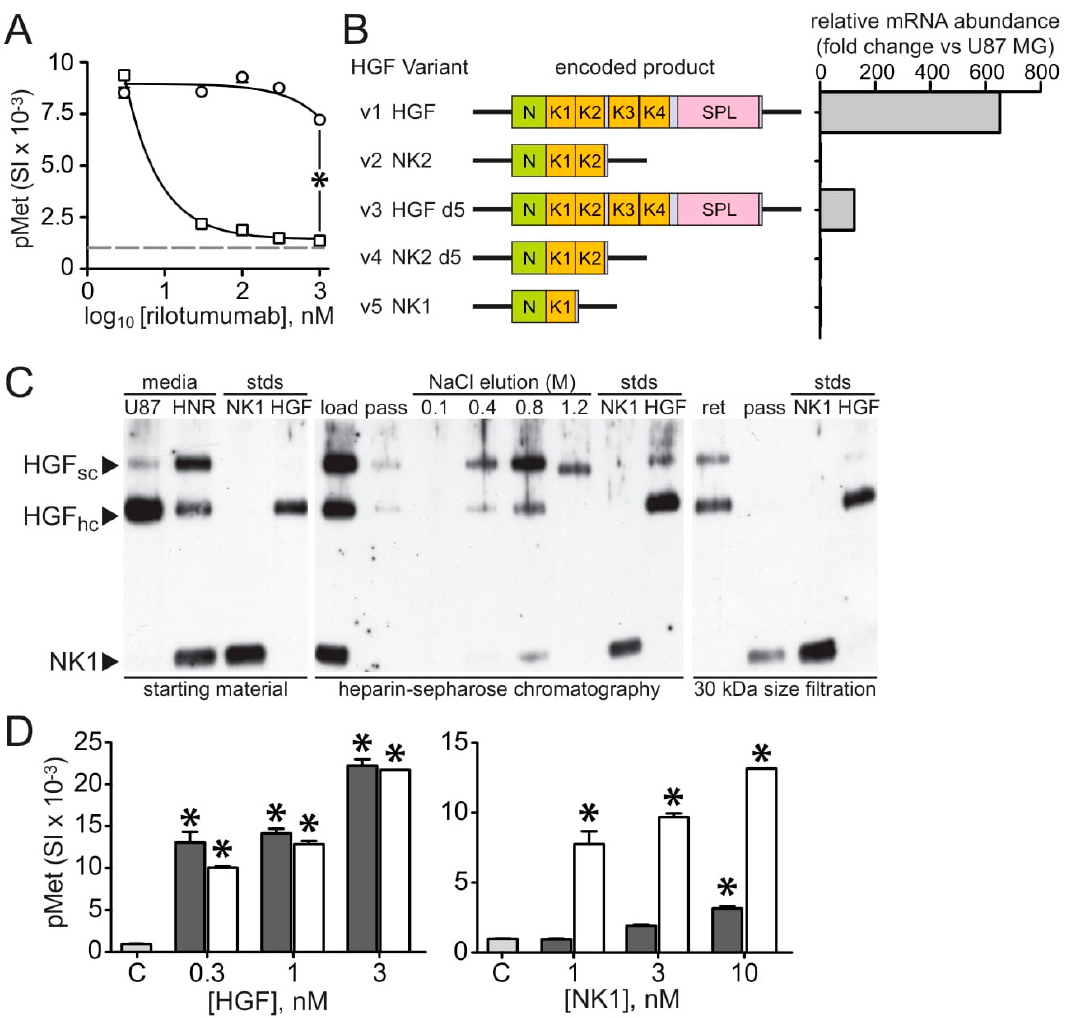
Figure 7. Potential route of rilotumumab resistance by production of a non-neutralizable trun- cated HGF protein. ( A ) Rilotumumab potently neutralizes Met autophosphorylation (pMet; mean signal intensity, SI ± SD, n = 3) in intact 184B5 cells induced by purified recombinant full-length HGF (squares) but not by the purified recombinant truncated HGF variant NK1 (circles). ( B ) Relative abundance (fold change vs. U87 MG; right) of all HGF mRNA transcript variants (listed and represented schematically at left) in U87 MG HNR as determined by quantitative PCR. ( C ) Reduced SDS-PAGE and immunoblot analysis of partial purification and size separation of HGF protein species present in U87 MG/HNR-conditioned media. Starting material (left panel) shows media (“media”) from U87 MG (“U87”) and U87 MG/HNR (“HNR”) contain single-chain (“HGF sc ”) and mature HGF heavy-chain (“HGF hc ”); an NK1-like protein (“NK1”) similar in size to purified recombinant NK1 (21 kDa, “stds”) is present only in the latter. HGF proteins from U87 MG/HNR media were partially purified using heparin-sepharose (center panel). Starting material before (“load”) and after (“pass”) application to the column are at left; the fraction (“NaCl elution”) eluting at 0.8 M NaCl was then dialyzed and sizing filtration (right panel) separated full-length (retained, “ret”) and truncated HGF (“pass”) forms. ( D ) Met activation (pMet) by partially purified full-length HGF (left panel, dark gray bars) and truncated HGF (NK1; right panel, dark gray bars) at indicated concentrations (nM) were compared with control media (“C”, light gray bars) and to purified recombinant HGF and NK1 protein standards (white bars). Asterisks indicate a significant difference from control ( p < 0.05). Steady-state levels of the five HGF transcript variants present in the parental and rilotumumab-resistant cell lines were compared by quantitative PCR. The left side of Fig- Media conditioned by the resistant cell line was partially purified by heparin Sepharose ure 7B schematically depicts the domain structures of the HGF transcript variants (v): v1 chromatography. SDS-PAGE and immunoblot analysis (Figure 7C, center) showed